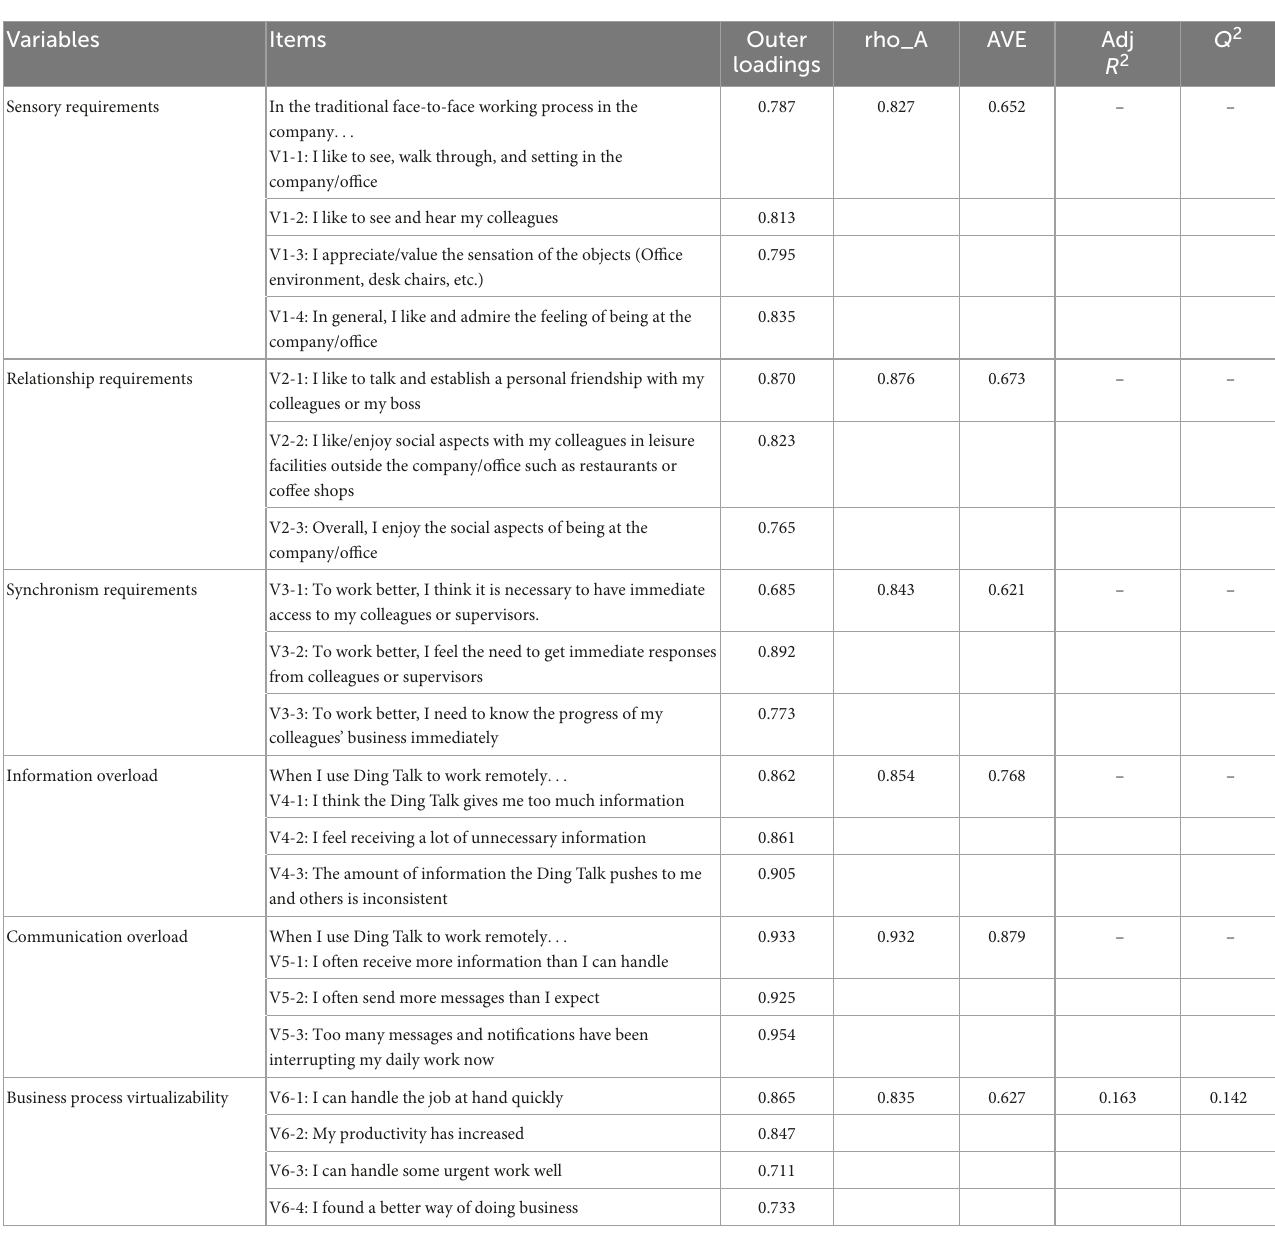
TABLE 2 Reliability tests for constructs and items.